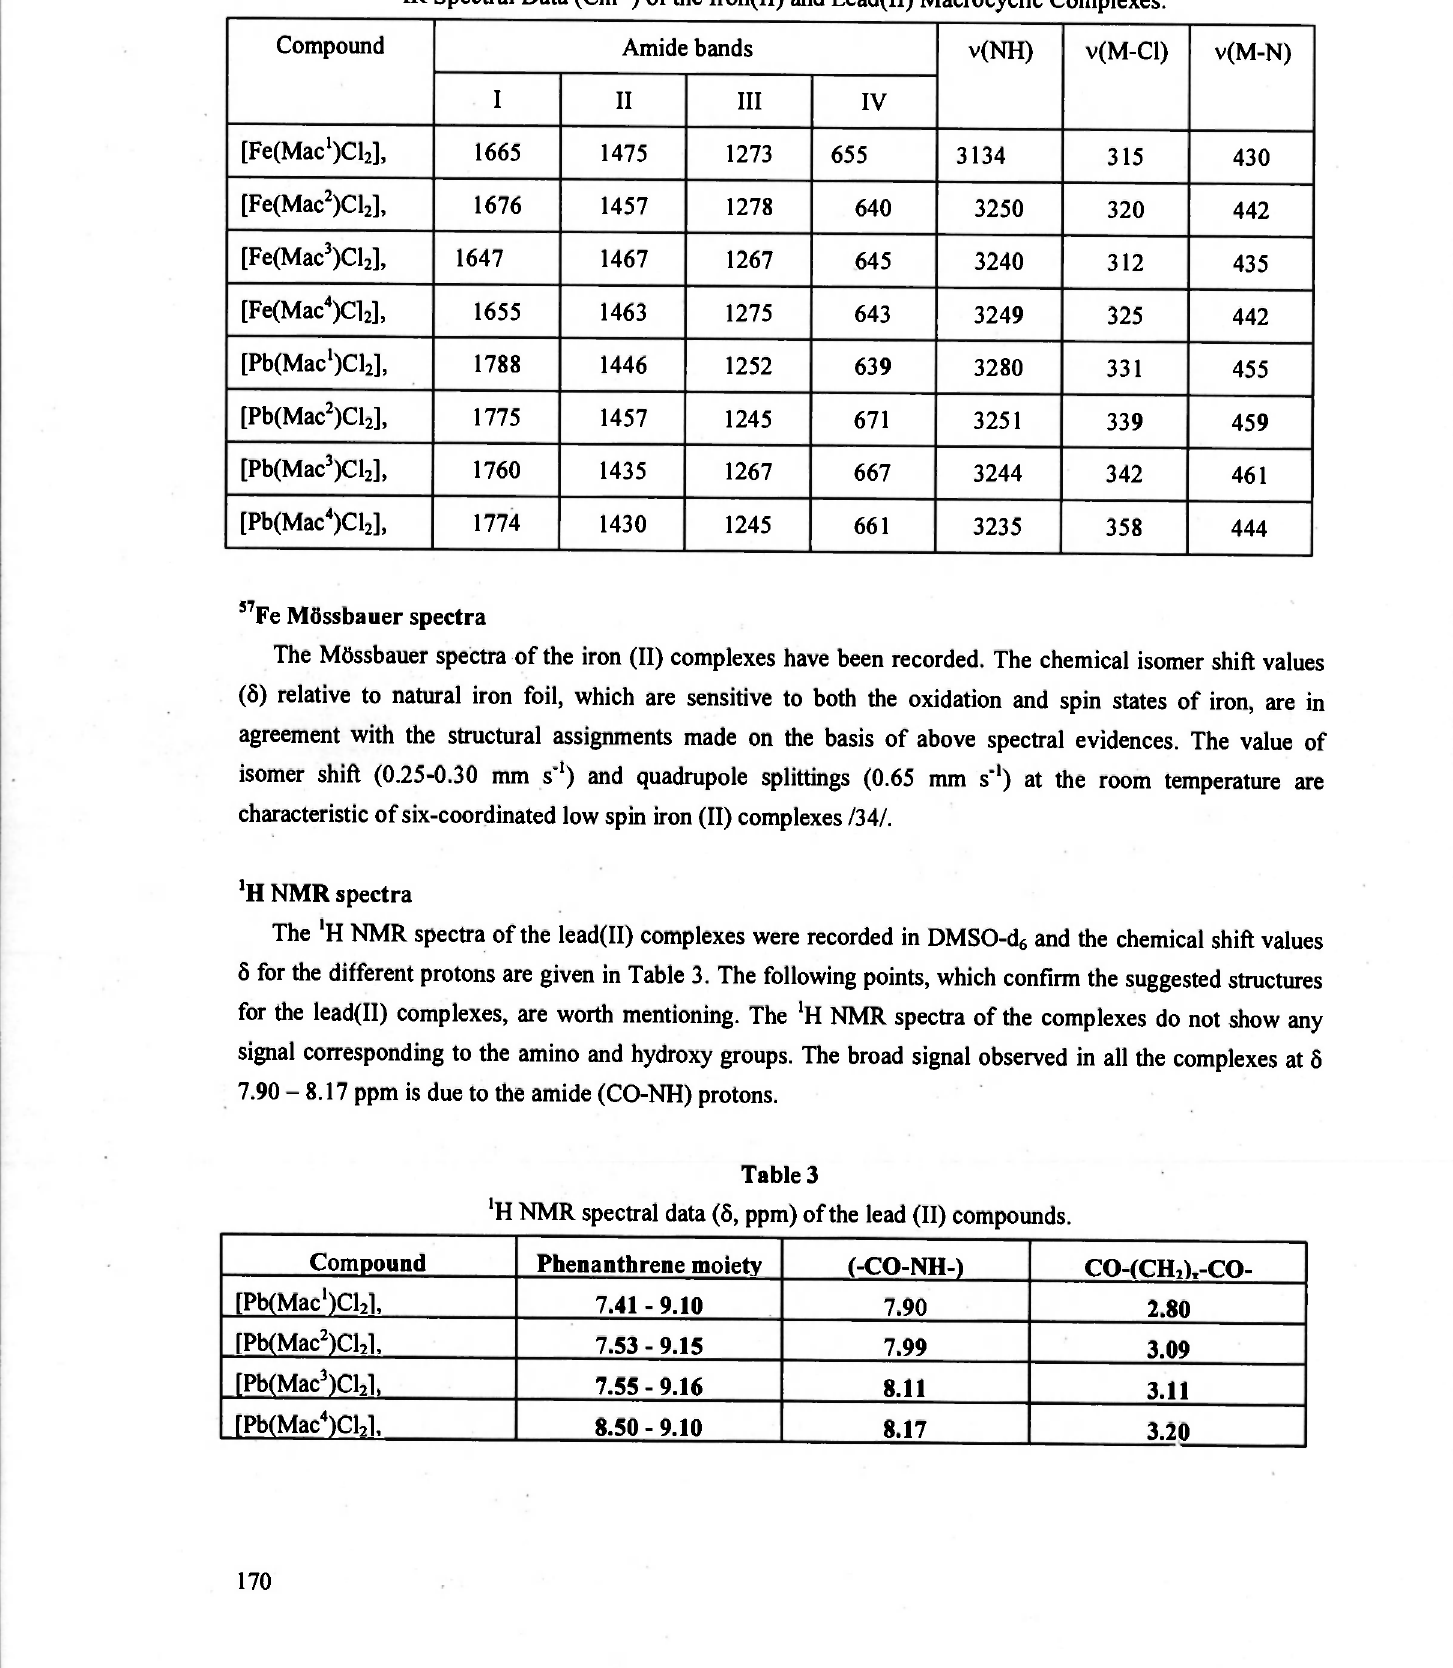
'H NMR spectral data (δ, ppm) of the lead (II)